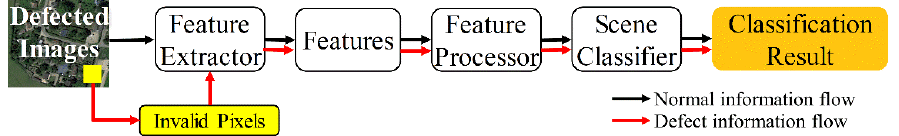
Figure 1. Existing RSISC task procedure. The invalid pixels induce a defect information flow (red line) and may influence the classification result. line) and may influence the classification